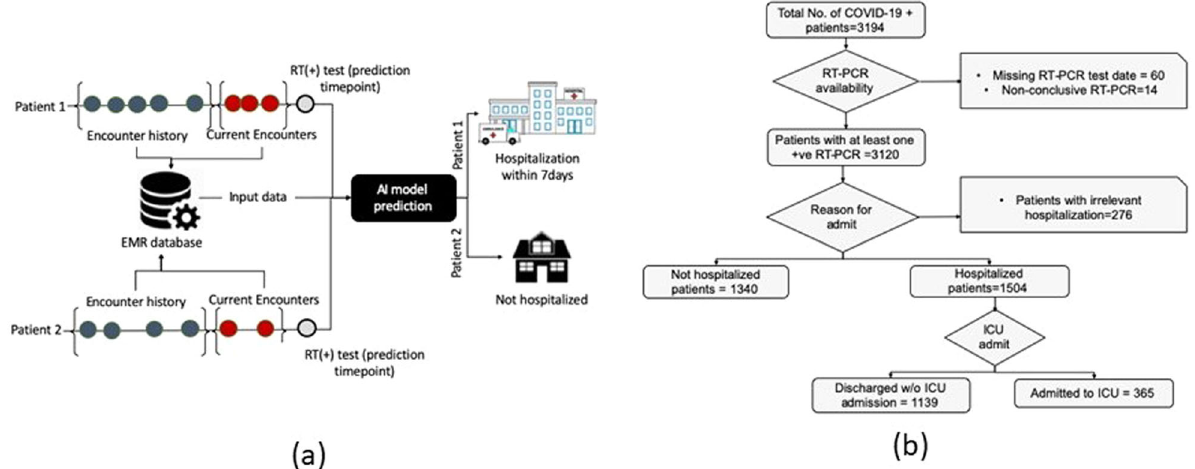
Fig. 1 Study design. a Proposed AI model decision point shows the prediction of two patients with distinct outcomes. b CONSORT diagram for Cohort selection process including decision nodes and a number of excluded